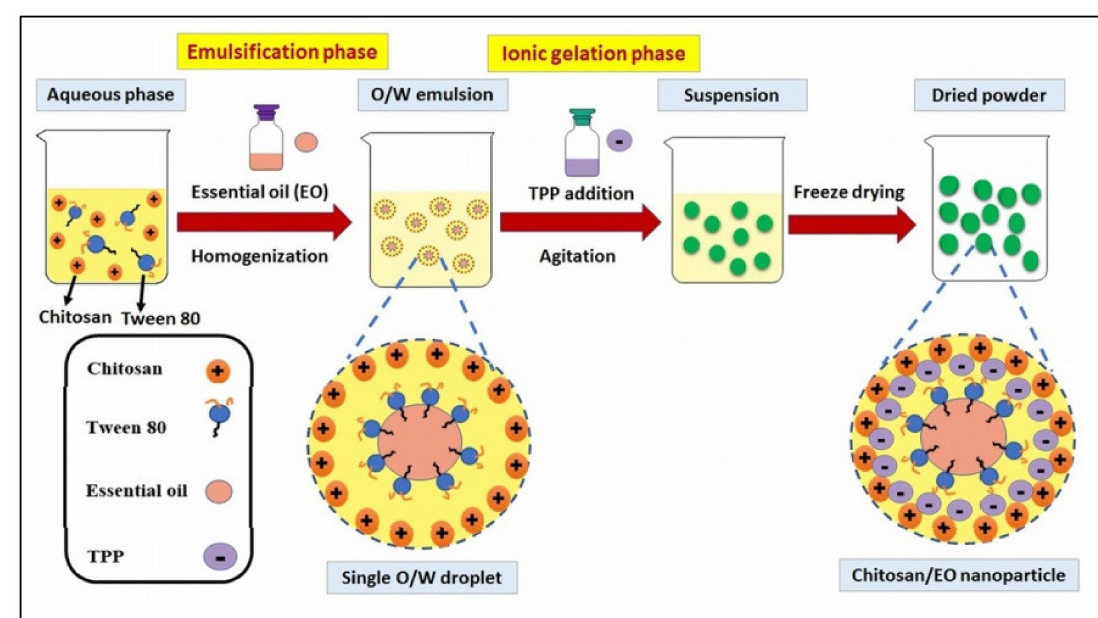
Figure 3. Schematic illustration of emulsification/ionic gelation procedure. Reprinted with permission from ref. [108]. Copyright 2019, Elsevier